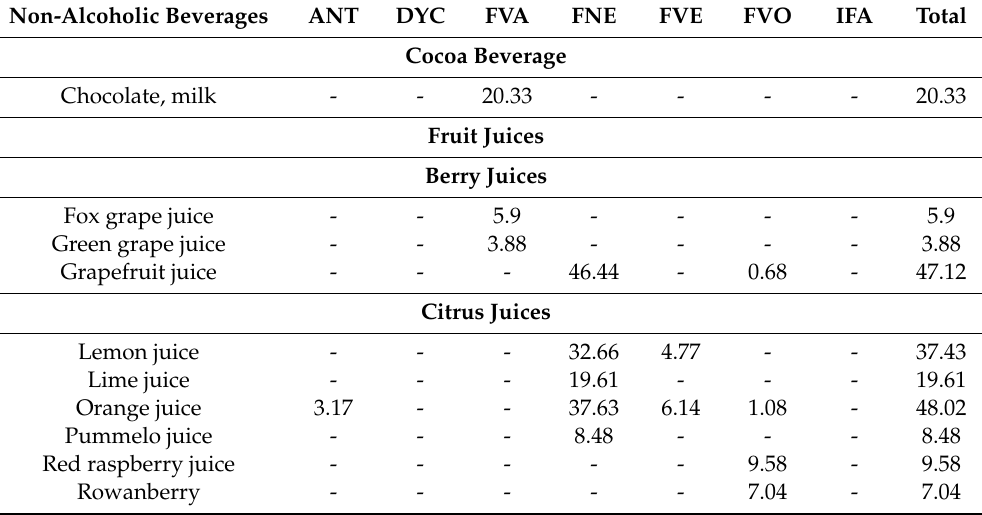
Table 7. Flavonoid contents of non-alcoholic beverages (mg / 100 g drink)